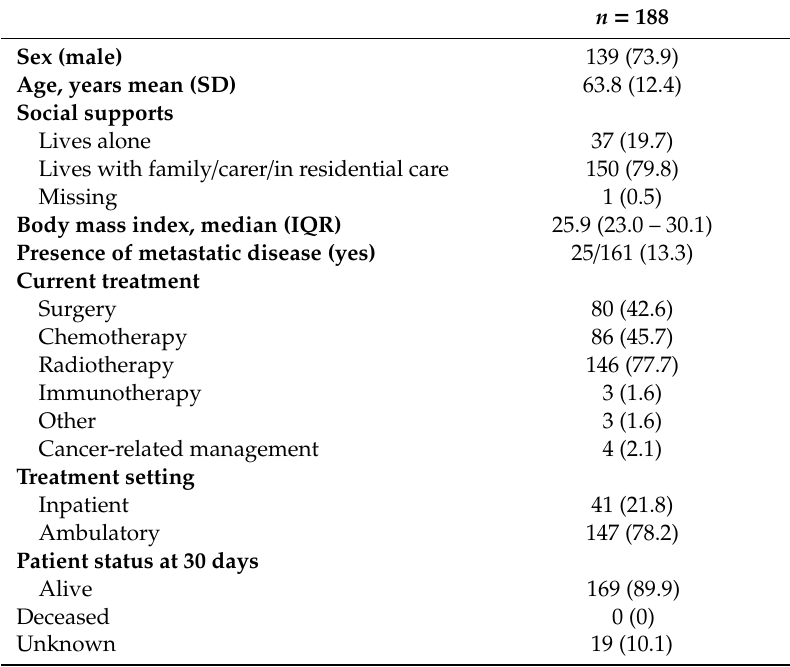
Table 3. Participant characteristics ( n = 188).